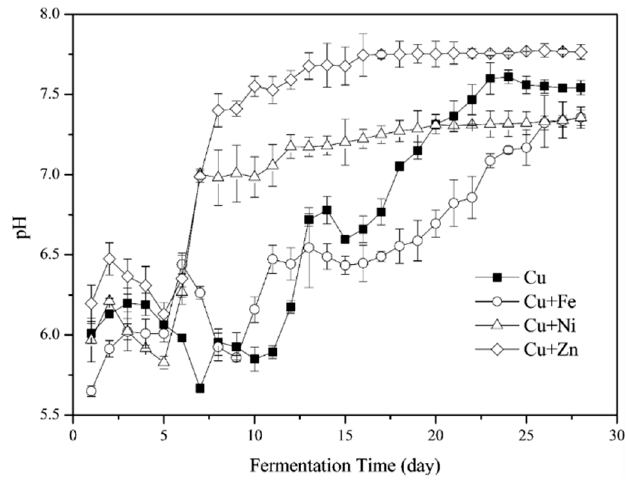
Figure 2. The pH values following the addition of Cu together with Fe, Ni, or Zn during the fermentation process.